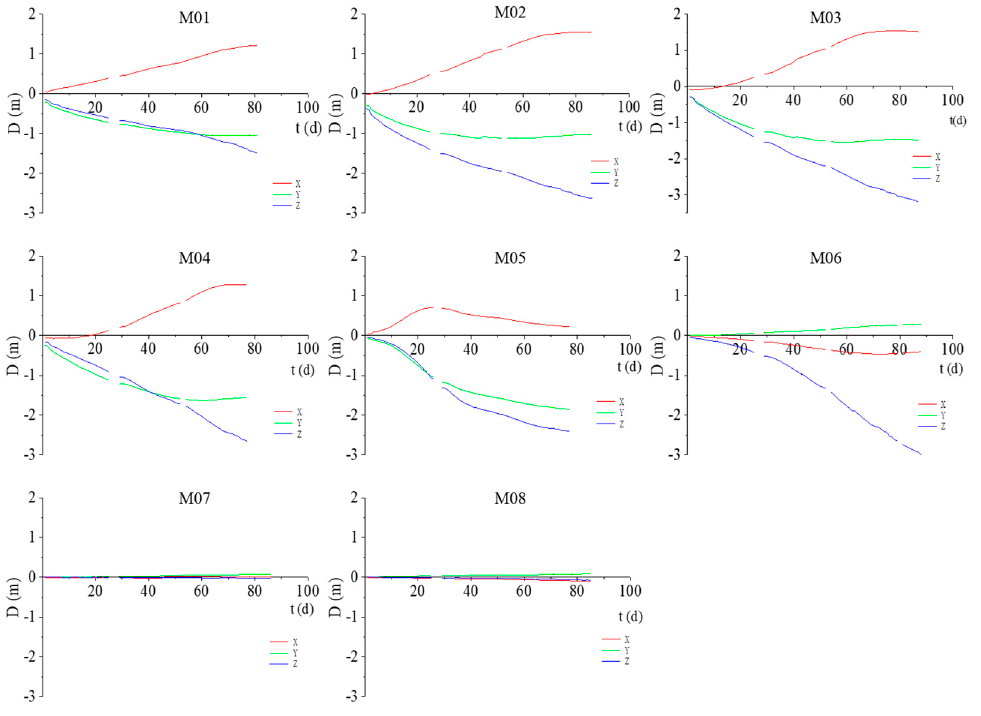
Figure 6. Ground displacement curves at the monitoring points.